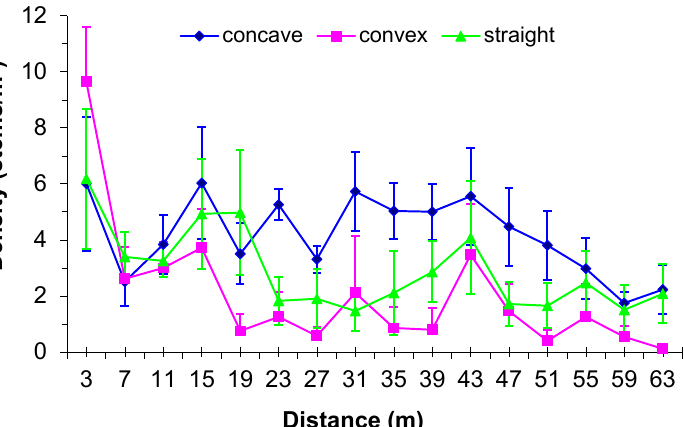
Figure 3. Average woody density (stems/m 2 ) and standard error according to the distance from the forest edge (m) in the three boundary types (concave, convex, and straight).